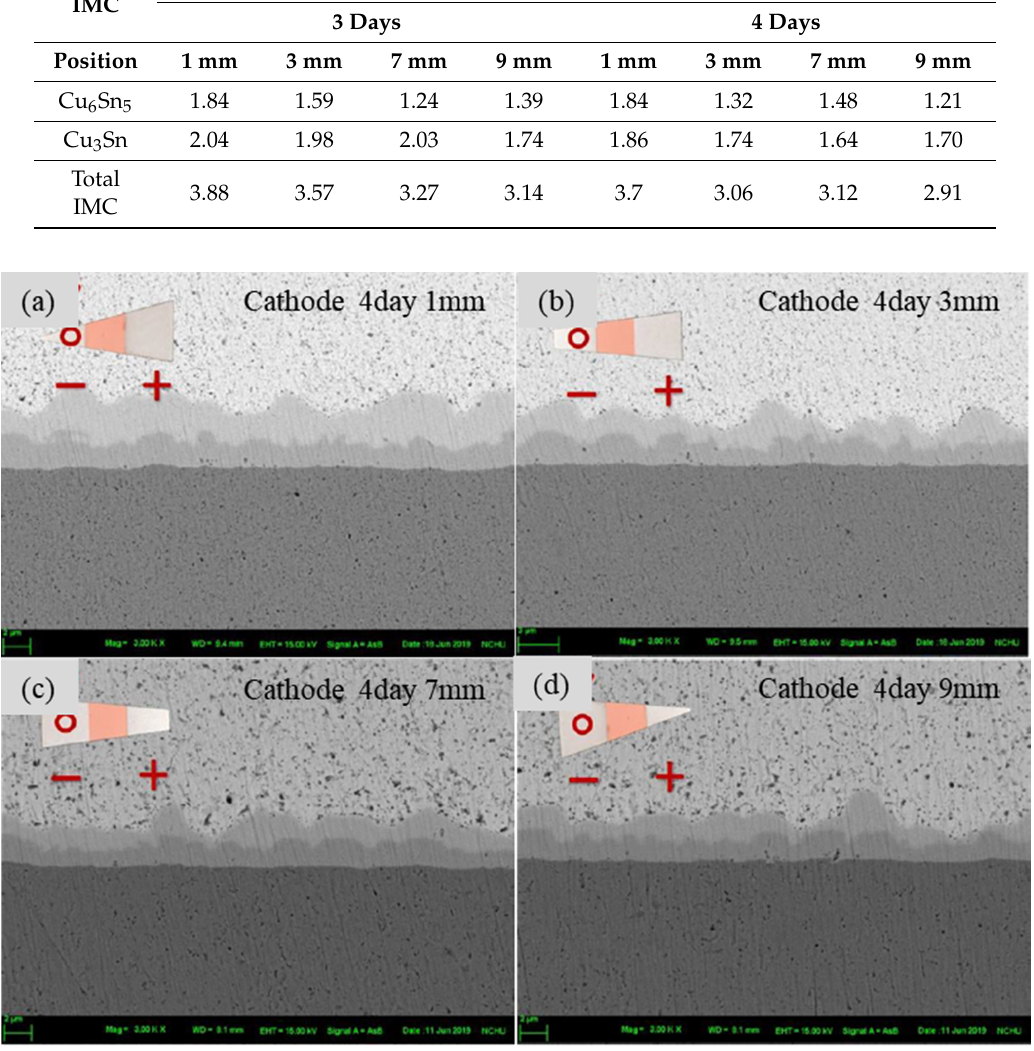
Figure 12. SEM images of various samples heated at 130 °C and subjected to a current of 0.8 A after 4 days. ( a ) Cathode ends (indicated on red circle) on the 1 mm side of 1:9 sample; ( b ) Cathode ends (indicated on red circle) on the 3 mm side of 3:7 sample; ( c ) Cathode ends (indicated on red circle) on the 7 mm side of 3:7 sample; ( d ) Cathode ends (indicated on red circle) on the 9 mm side of 1:9 sample.